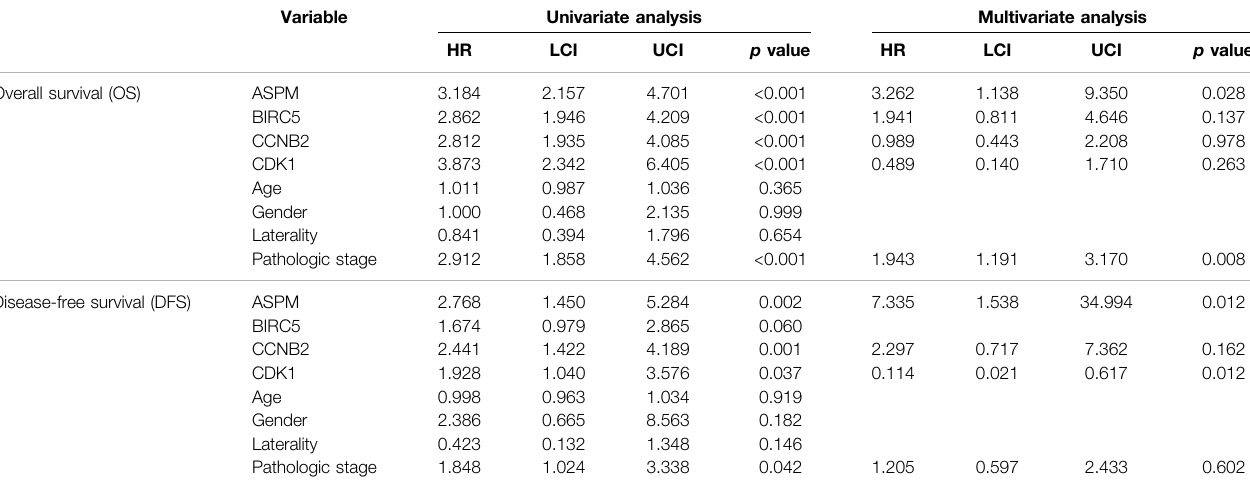
TABLE 4 | Cox univariable and multivariable analyses of overall survival (OS) and disease-free survival (DFS). Variable Univariate